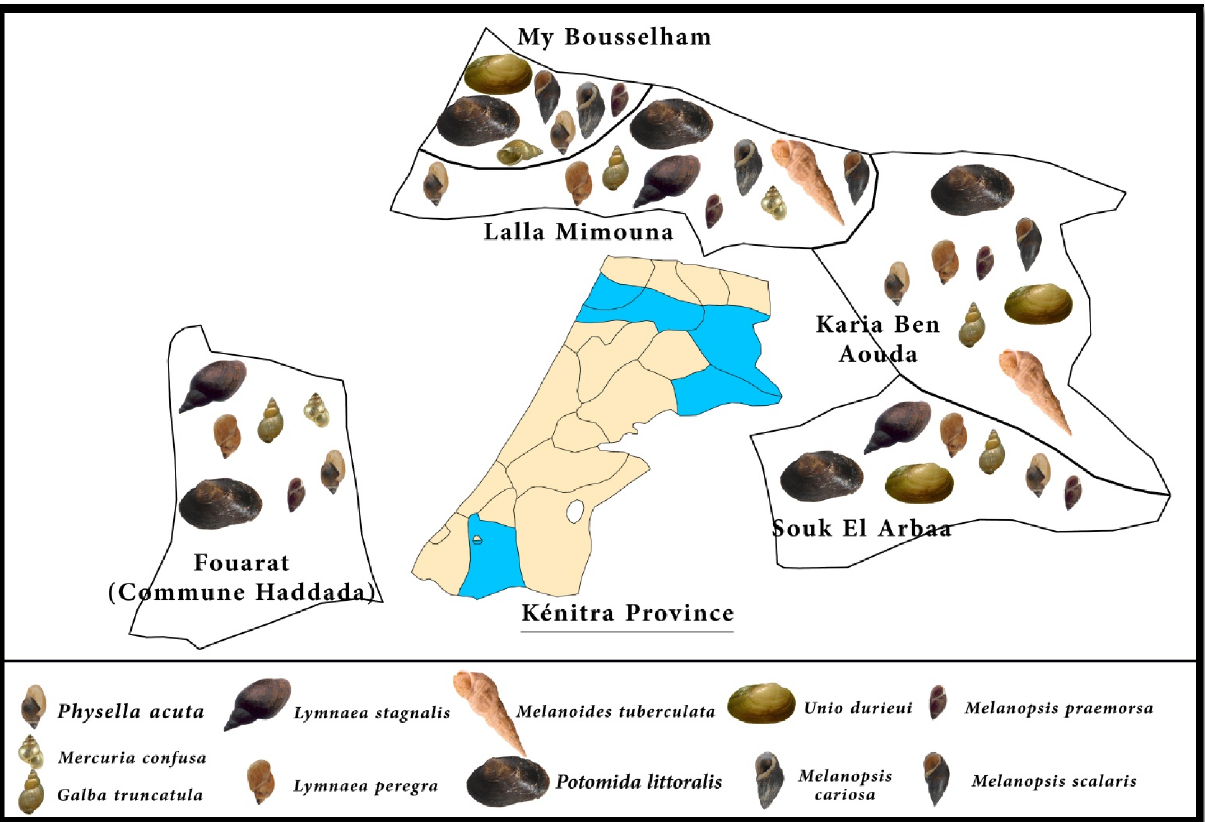
Figure 3. Species richness in the Gharb region (May 2012 to May